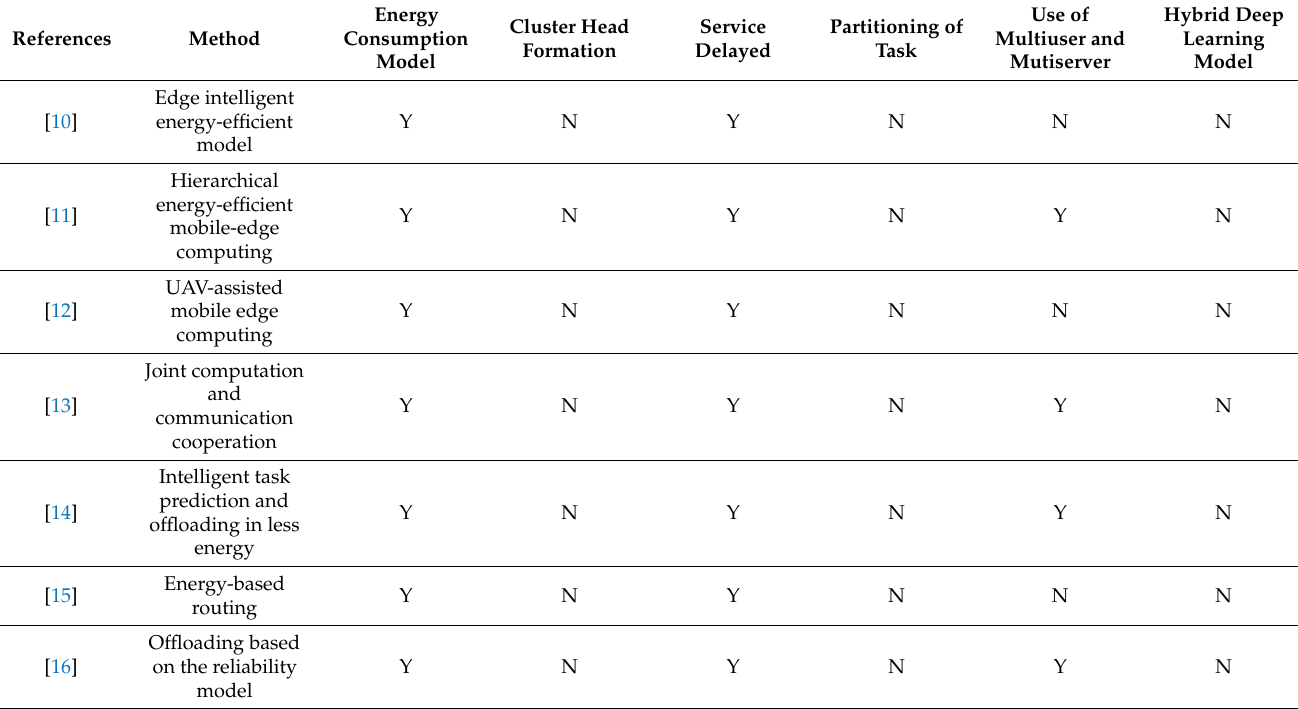
Table 1. Comparative analysis of existing